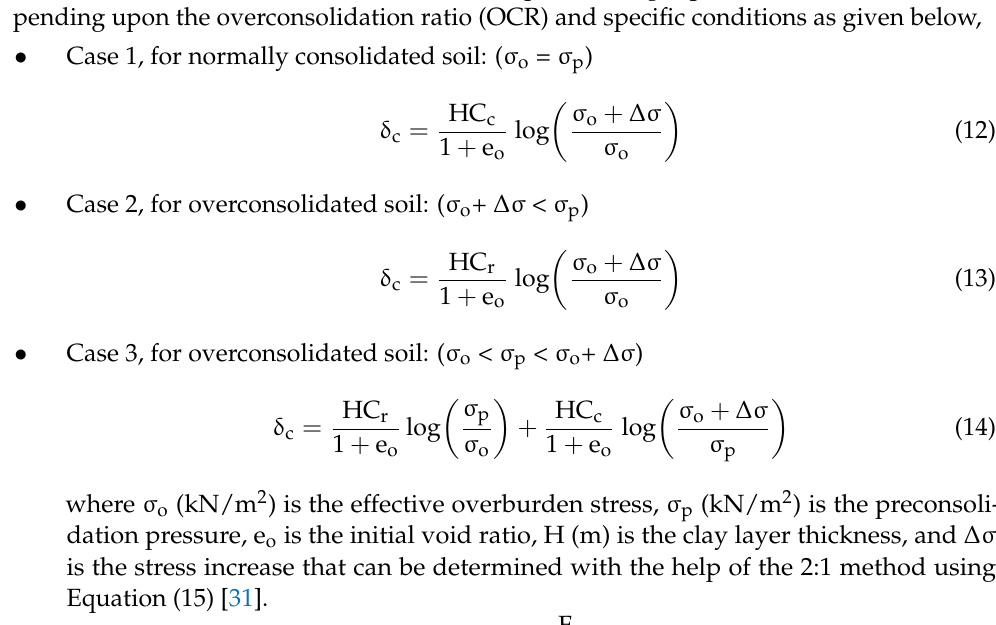
Figure 1. Effect of L/B on shape factor β z.